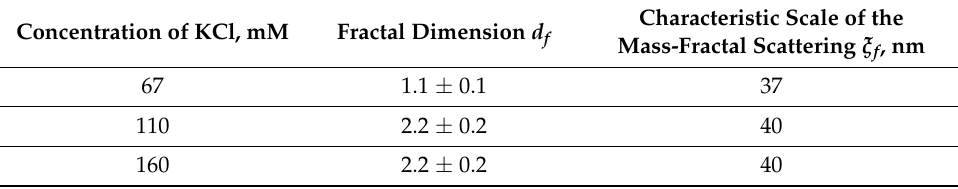
Table 1. Fractal dimensions d f and characteristic scales ξ f of the mass-fractal scattering in the solutions of saturated P4VP/potassium oleate complexes in the presence of different concentrations of KCl, obtained upon matching the scattering from P4VP (solvent: 37 vol% D 2 O/63 vol% H 2 O at pH 11). Characteristic Scale of the Concentration of KCl, mM Fractal Dimension d f Mass-Fractal Scattering ξ f , nm 67 1.1 ±